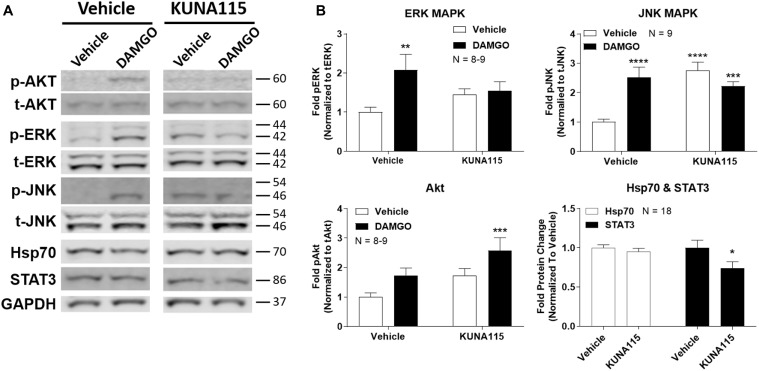
Hsp90α regulates opioid signal transduction in the brain. Male CD-1 mice had vehicle or 0.1 nmol KUNA115 injected icv, 24 h, followed by vehicle or 0.1 nmol DAMGO icv, 10 min. Periaqueductal gray region analyzed by Western blot. All data reported as the mean ± SEM, with sample sizes of mice/group noted in each graph; all experiments performed in four technical replicates. For ERK, JNK and Akt, data analyzed by two-way ANOVA with Fisher’s Least Significant Difference post hoc test; **,***,****p < 0.01, 0.001, 0.0001 vs. Vehicle:Vehicle group. For Hsp70 and STAT3 data analyzed by Unpaired 2-Tailed t-test; *p < 0.05 vs. same target Vehicle group. (A) Representative sample blots shown for each target, with MW indicated for each protein. Each pair of images for one target (e.g., p-Akt) were from the same blot, but discontinuous, so they are separated to denote this fact. (B) All Western data quantitated by target. ERK, JNK, and Akt are phosphorylated protein signal normalized to total protein. Hsp70 and STAT3 are normalized to GAPDH. KUNA115 treatment caused a loss of ERK and JNK stimulation over baseline by DAMGO, and a loss of STAT3 protein expression.